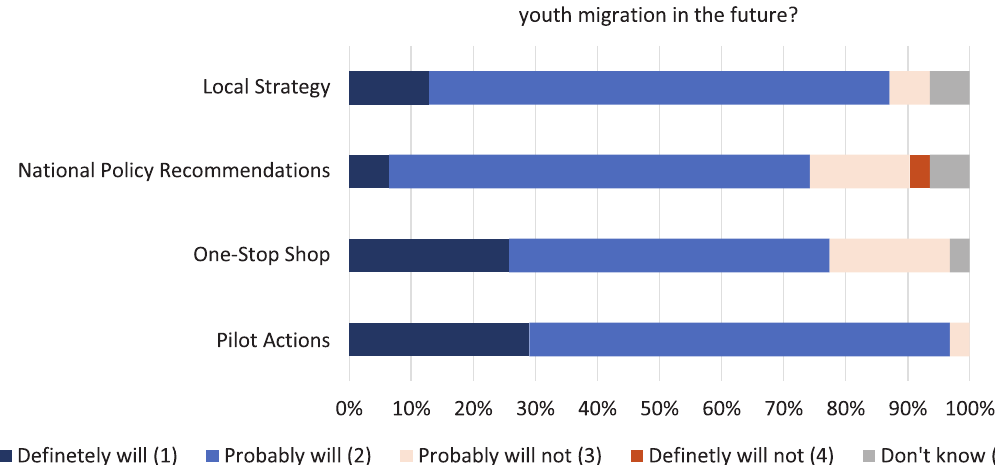
Figure 2. Results from the evaluation survey on the estimation of the sustainability of final project